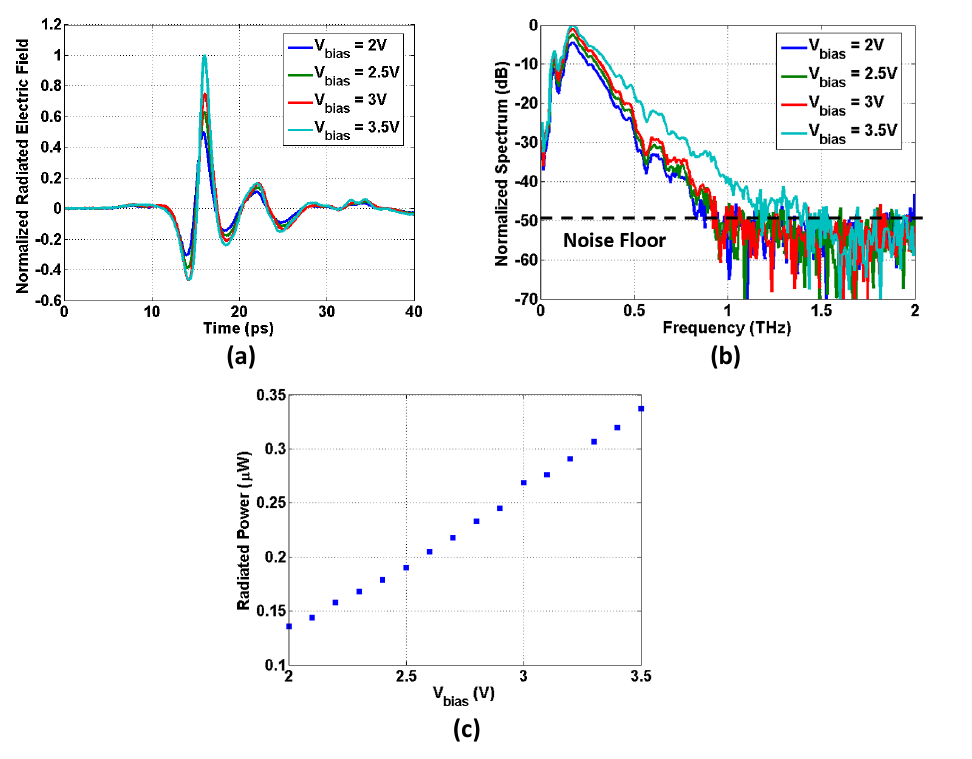
Figure 8. Measured effects of bias voltage on the radiated THz impulse. ( a ) Effects on the peak amplitude of the radiated THz impulse. ( b ) Effects on the SNR > 1 bandwidth of the radiated THz impulse. ( c ) Effects on the average radiated